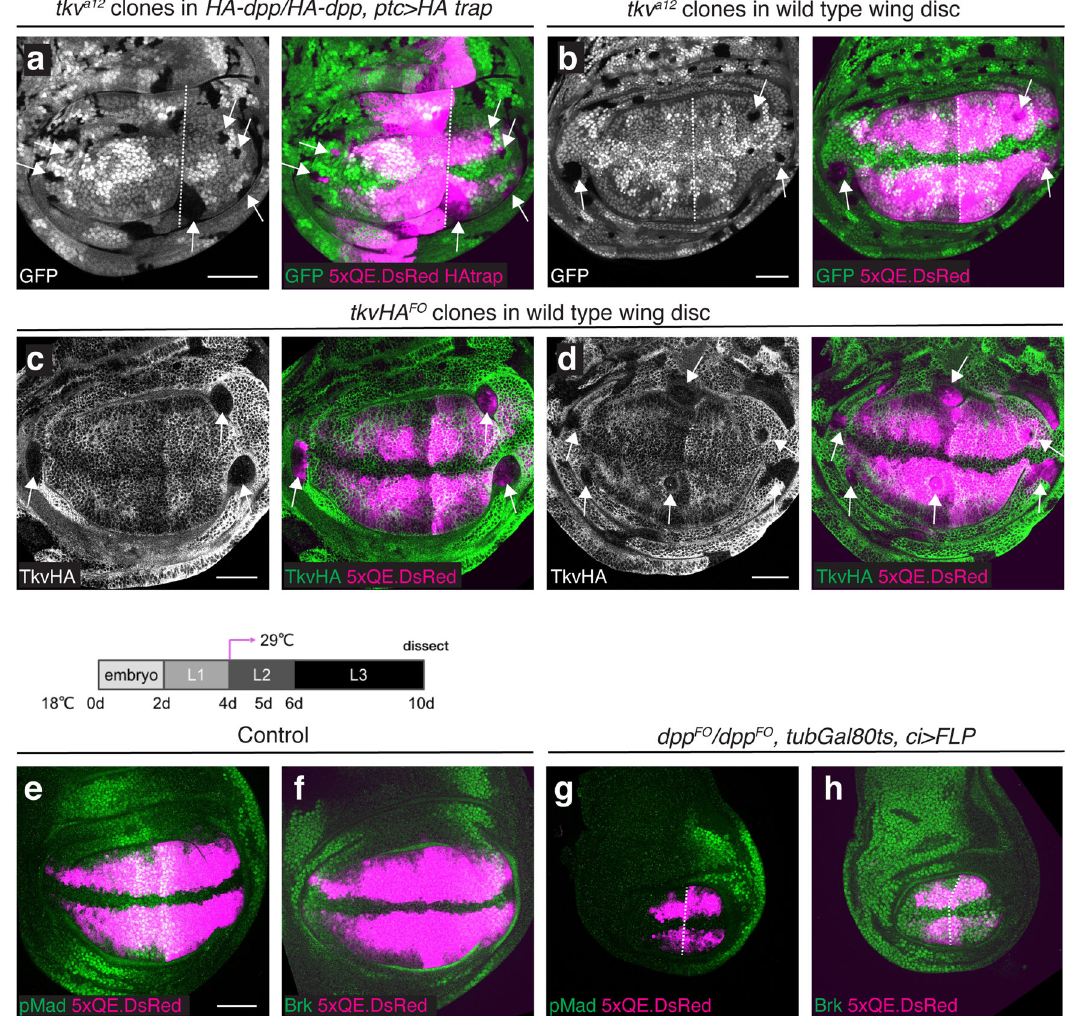
Fig. 4 Lateral wing pouch growth without Dpp signaling. a , b tkv a12 clones (indicated by the absence of GFP signal) induced in HA-dpp/HA-dpp, ptc > HA trap wing discs ( a ) and in wild-type wing discs ( b ). c , d tkvHA FO clones (indicated by the absence of α -HA staining) in wild-type wing discs. Clones were induced at 60 − 72 h AEL (after egg laying) during mid-second to early third instar stages. e − h α -pMad and 5xQE.DsRed ( e , g ) and α -Brk and 5xQE.DsRed ( f , h ) of control wing disc ( e , f ) and 5xQE.DsRed, dpp FO /dpp FO , tubGal80ts , ci > UAS-FLP wing disc ( g , h ). Crosses were shifted from 18 °C to 29 °C at 4-day AEL (early second instar). Scale bar 50 μ